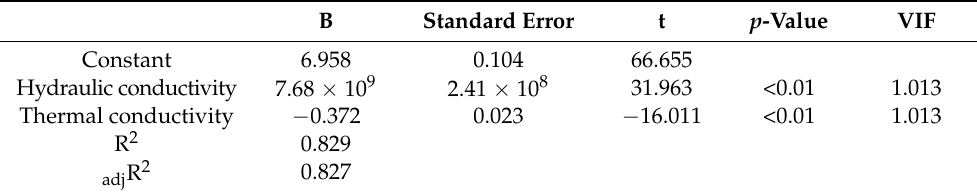
Table 3. Regression analysis between three